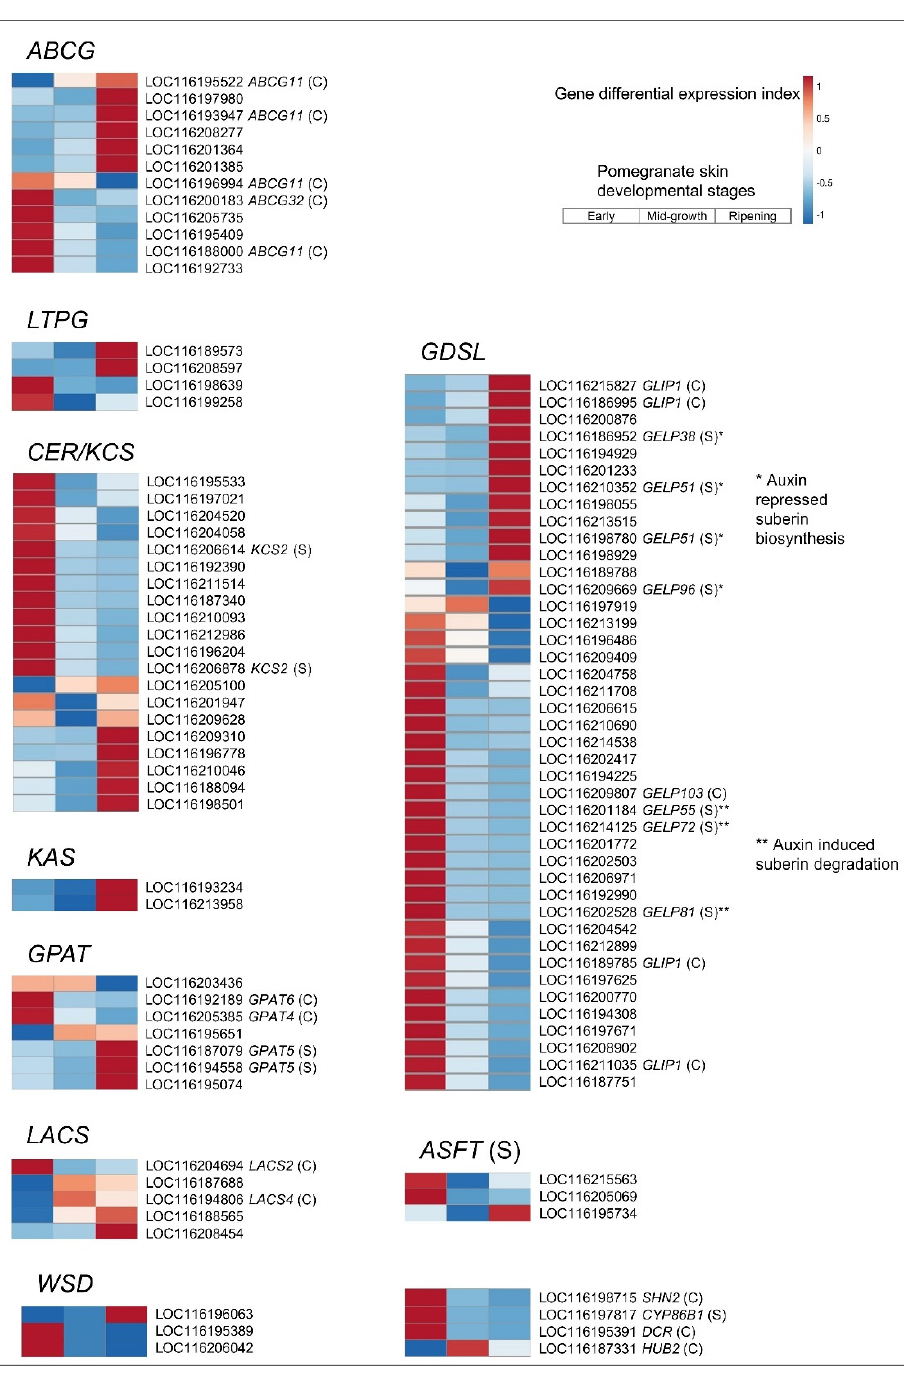
Figure 8. Cutin and suberin biosynthesis genes in pomegranate skin. See Figure 3 legend for details. Arabidopsis orthologs’ gene codes are indicated next to the pomegranate gene ID; (C) and (S) indicate verified involvement in cutin and suberin biosynthesis, respectively, based on [65,66]. Expression level values and full gene names are given in Table S12.